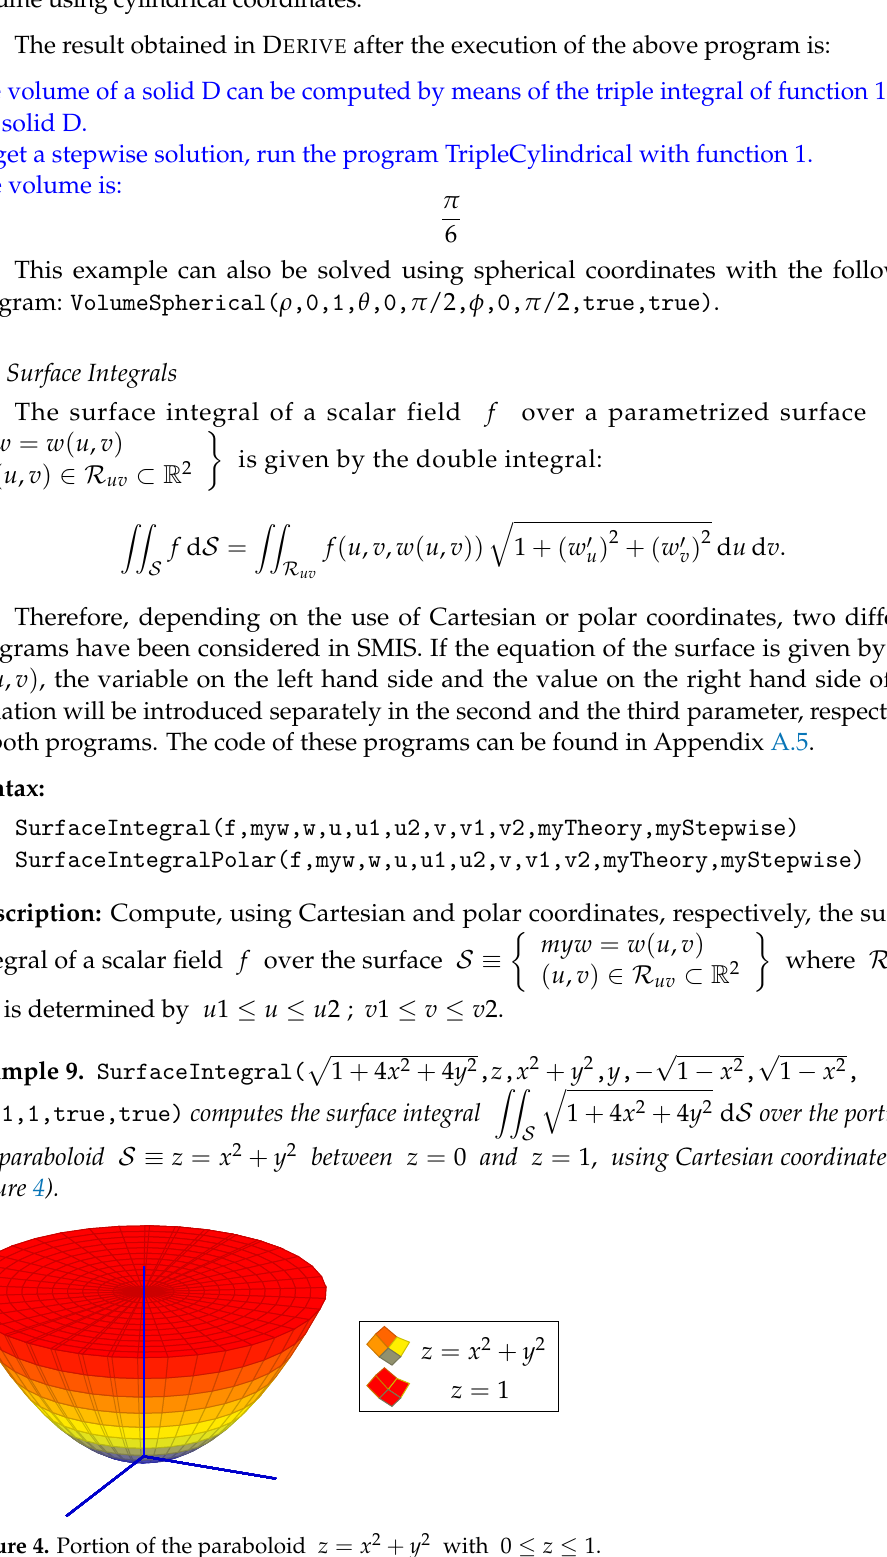
Figure 4. Portion of the paraboloid z = x 2 + y 2 with 0 ≤ z ≤